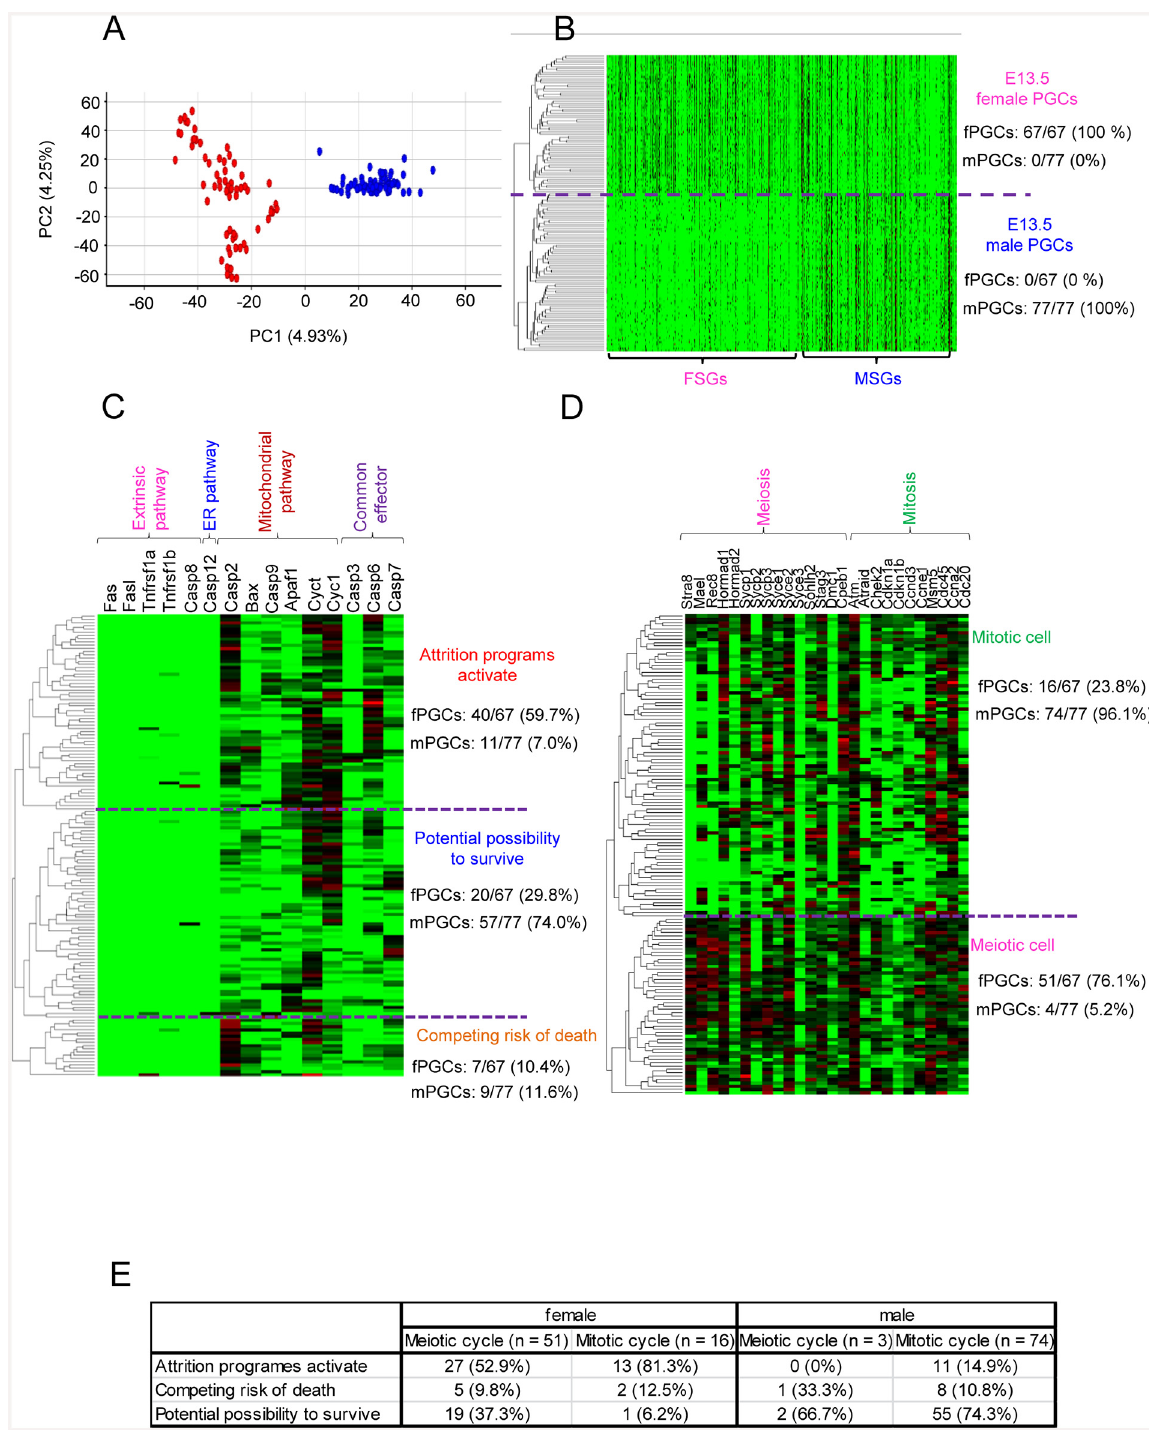
Fig 6. Single-cell transcriptome analysis of E13.5 female and male PGCs. (A) Bi-dimensional PCA of E13.5 female and male single-PGC gene expression patterns. The first principal component (PC1) captures 4.93% of the gene expression variability and the second principal component (PC2) captures 4.25%. The red and blue spheres represent single female (n = 67) and male (n = 77) PGCs, respectively. (B) Hierarchical clustering analysis of transcriptome data sets (FSG: 651, MSG: 428) of female and male single PGCs. (C) Heat map of the relative expression of apoptotic process-related genes (n = 15). (D) Heat map of the relative expression of meiotic and mitotic cell cycle-related genes (n = 26). (E) Relation between apoptosis and meiotic and mitotic cell cycle in female PGCs. The numbers indicate the number of PGCs.